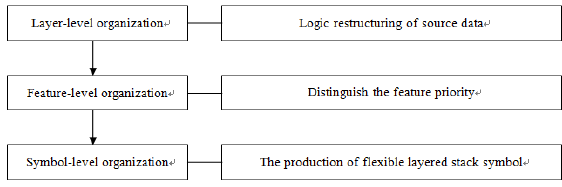
Fig.3 Organization hierarchy structure of